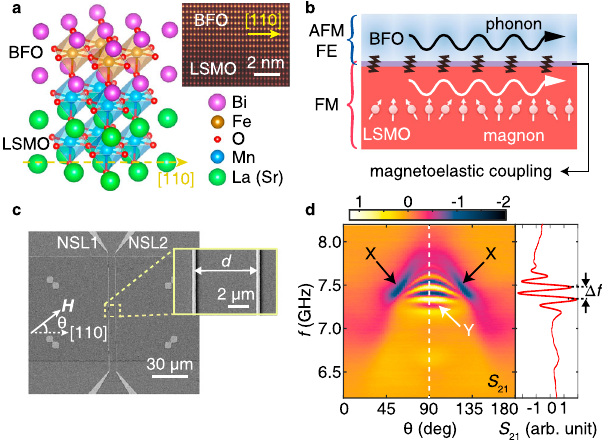
Fig. 1 BFO/LSMO heterostructures and spin-wave transport. a A schematic diagram of the interface of the BiFeO 3 (BFO)/La 0.7 Sr 0.3 MnO 3 (LSMO) heterostructure. The inset shows the atomically resolved interface of BFO/ LSMO by annular dark fi eld image. The yellow arrow indicates the pseudo- cubic [110] crystalline orientation of LSMO and BFO. b A schematic illustration of magnon – phonon coupling in the BFO/LSMO heterostructure. The system consists of two layers: The top layer BFO is multiferroic being both antiferromagnetic (AFM) and ferroelectric (FE) and hosts a longitudinal acoustic (LA) wave mode. The bottom layer consists of the ferromagnetic (FM) LSMO layer with an in-plane uniaxial anisotropy. The phonons in BFO and magnons in LSMO are hybridized via magnetoelastic coupling at the interfacial layer owing to the interfacial exchange coupling between LSMO and BFO and magnetoelastic interaction within the BFO. c A scanning electron microscope (SEM) image of a magnonic device for measuring spin-wave transmission. The fi eld is applied in the plane and rotated with respect to the [110] crystalline orientation of BFO (LSMO). The inset is a zoom-in image showing two integrated gold antennas NSL1 and NSL2 with a center-to-center distance d ¼ 6 μ m. d Spin-wave transmission spectra S 21 (spin waves excited at NSL1 and detected at NSL2), where mode X and Y are marked. A single spectrum is extracted at θ ¼ 90 (cid:3) , from which a frequency span 4 f is extracted for the derivation of the spin-wave group velocity used in Eq. (1). The data displayed in the map is the imaginary part of the transmission spectra, and the color bar denotes the amplitude of the imaginary part, which is in arbitrary